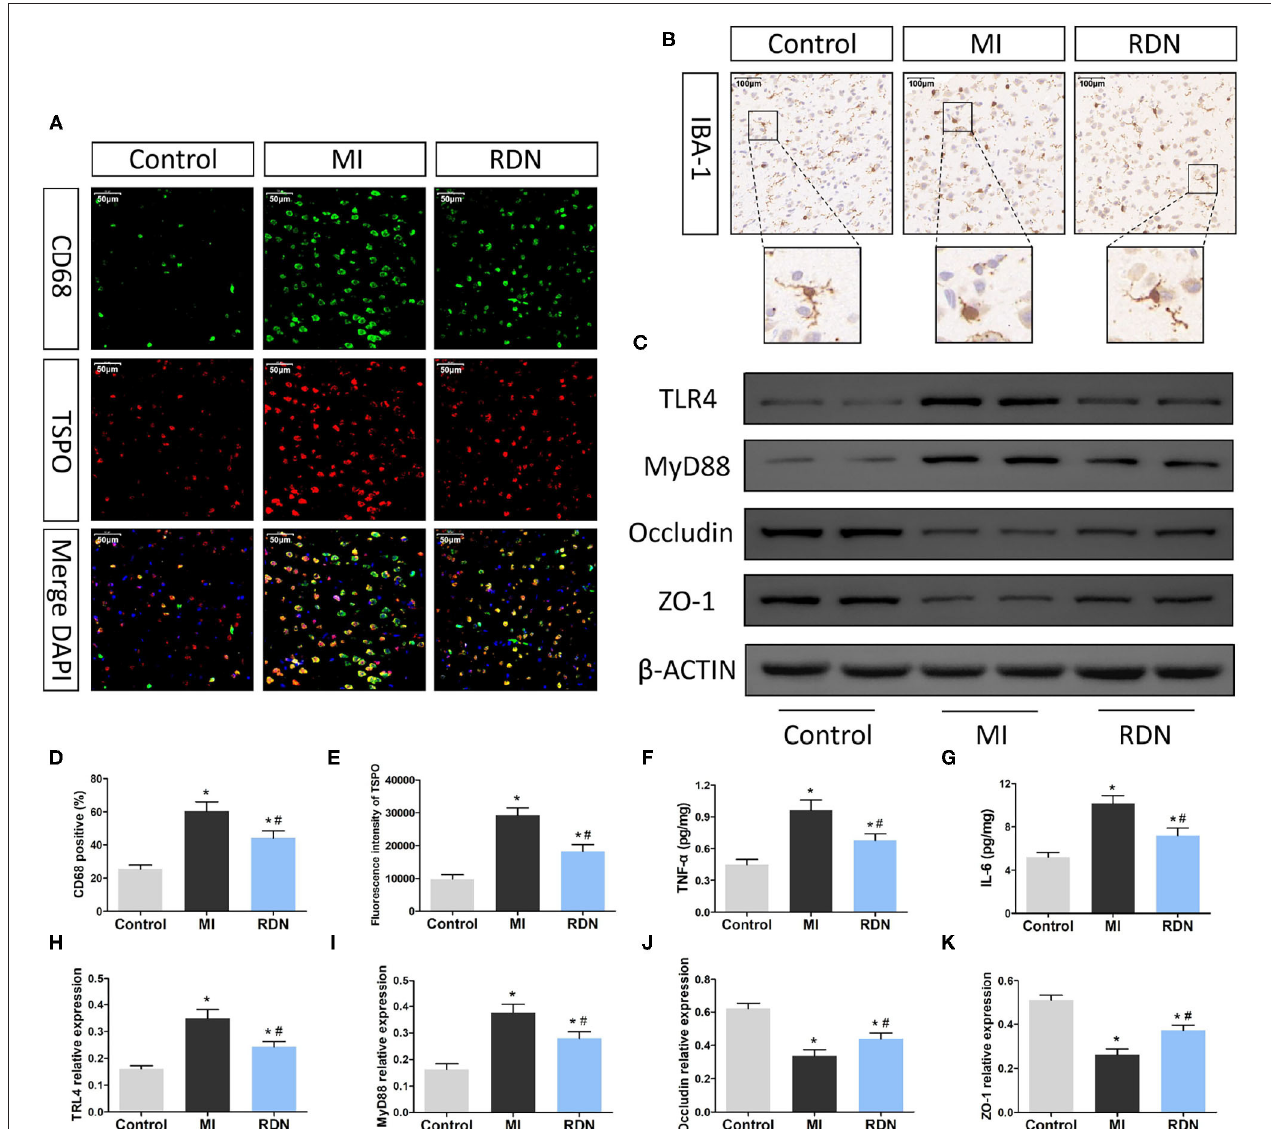
FIGURE 4 | RDN ameliorates the MI-related neuroinflammation in the CNS of rats. (A) Immunofluorescent analysis of TSPO and CD68 expression (magnification, 400 × ) in the brain of rats. (B) Immunohistochemsitry analysis of Iba-1 expression (magnification, 200 × ) in the brain of rats. (C) Western blotting analysis of the relative levels of TLR4, MyD88, Occludin, ZO-1, and the control β -actin expression in the brain of rats. (D) Quantitative analysis of CD68 + microglia in the brain. (E) Quantitative analysis of TSPO fluorescent signals in the brain. (F,G) ELISA analysis of TNF- α and IL-6 in the brain. (H–K) Quantitative analysis of TLR4, MyD88, Occludin, and ZO-1 expression in the brain of rats. Data are representative images or expressed as the mean ± SEM of each group of rats from three separate experiments. * P < 0.05 vs. the Control group; # P < 0.05 vs. the MI group. TSPO, translocator protein; DAPI, 4’,6-diamidino-2-phenylindole; Iba-1, ionized calcium binding adaptor molecule-1; TLR4, Toll-like receptor 4; MyD88, myeloid differentiation factor